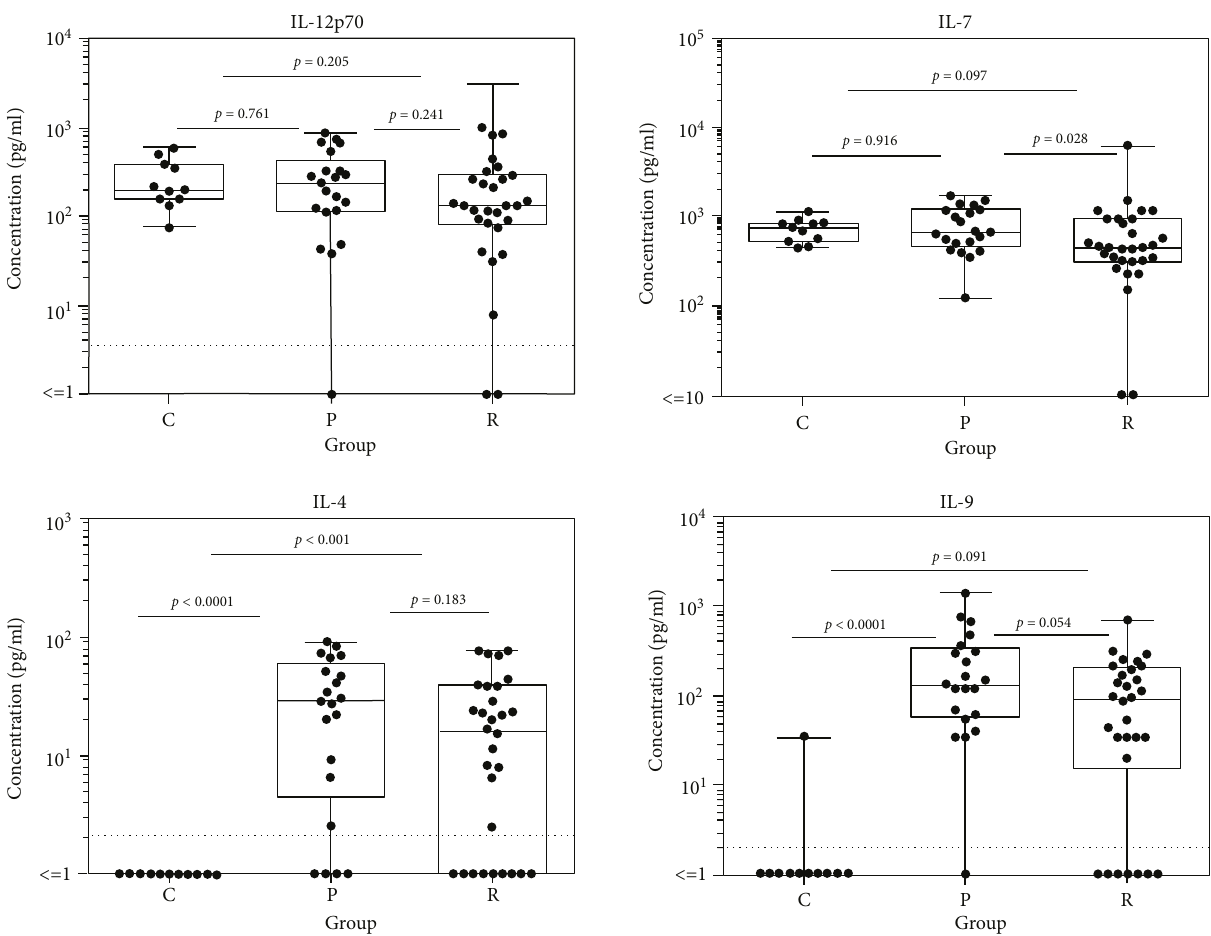
Figure 2: Box plots depicting the cytokine patterns of T cytokines IL-4 and IL-9 in aqueous humor comparing results of patients with pOT ( n = 21 ) and rOT ( n = 30 ) and the control group ( n = 11